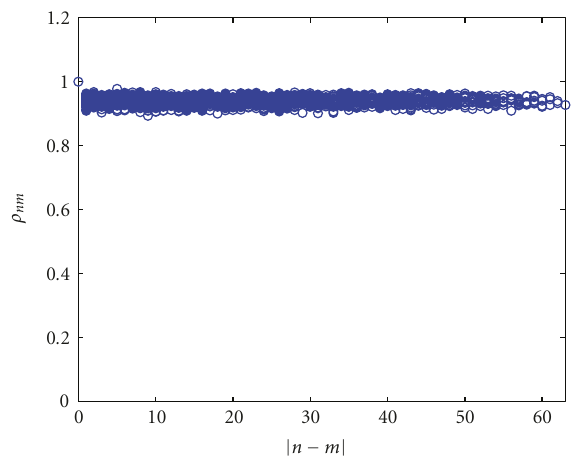
Figure 8: The normalized cross-correlation coe ffi cients of the 64- hydrophone synthesized aperture.